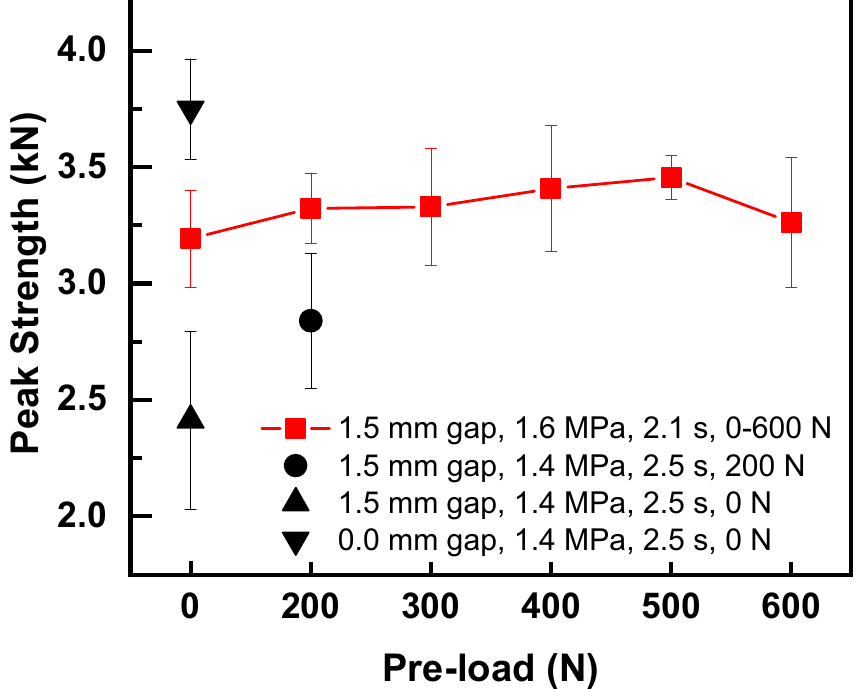
Figure 9. Effect of preload on the strength of joint with a gap of 1.5 mm. To investigate the repairing mechanism of the application of preload, the fracture surfaces of joints under various preloads were examined as shown in Figure 10. Weld area of joints with preloads of 0, 200, 400, and 500 N were 167.8 mm 2 , 269.3 mm 2 , 309.8 mm 2 , and 350.5 mm 2 , respectively. The weld area increased with increasing preload, which implies the preload can improve the contact between the upper and lower workpieces for joint with a gap of 1.5 mm and enhance the wave energy transmission and absorption.